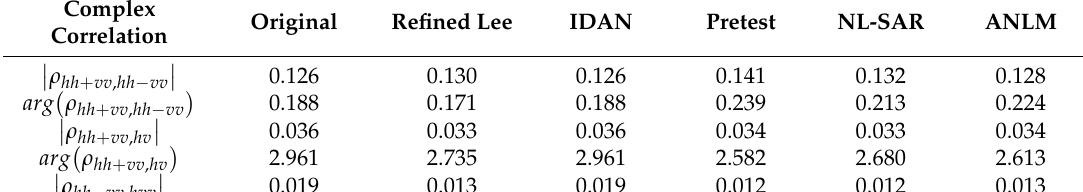
Figure 8. Enlarged details on the marked region 2. ( a ) Original data. ( b ) Refined Lee filter. ( c ) IDAN